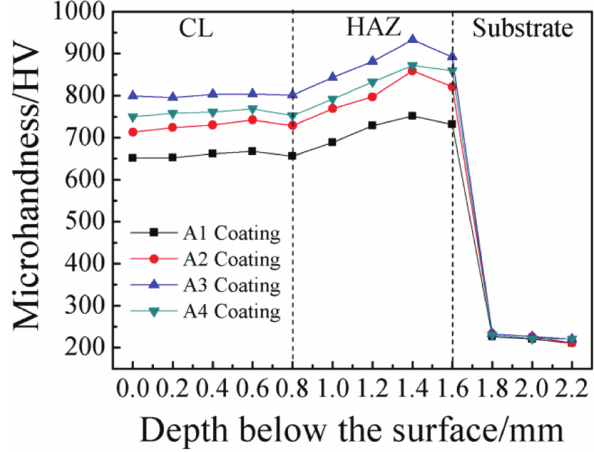
Figure 8: Micro-hardness distribution of the composite